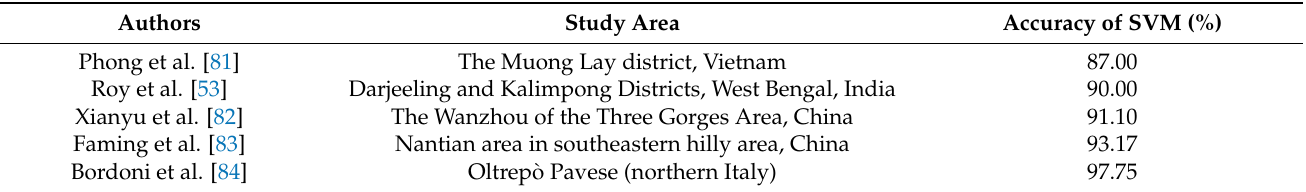
Table 4. The accuracy of the SVM model in different areas.